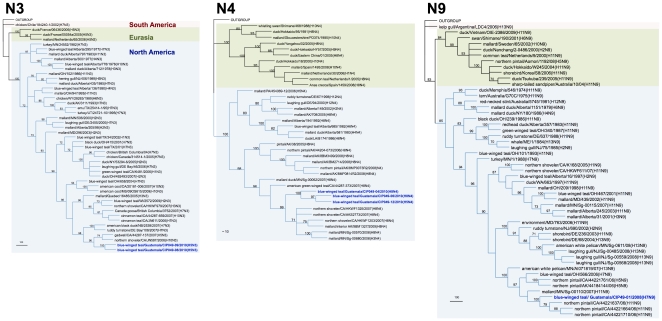
Phylogenetic trees for N3, N4, and N9 NA genes.Trees were generated in PAUP 4.0b10 using the Neighbor-Joining method with 1000 bootstrap replicates (bootstrap values above 70% are shown). Scale bar on the bottom-left indicates number of nucleotide substitutions per site.